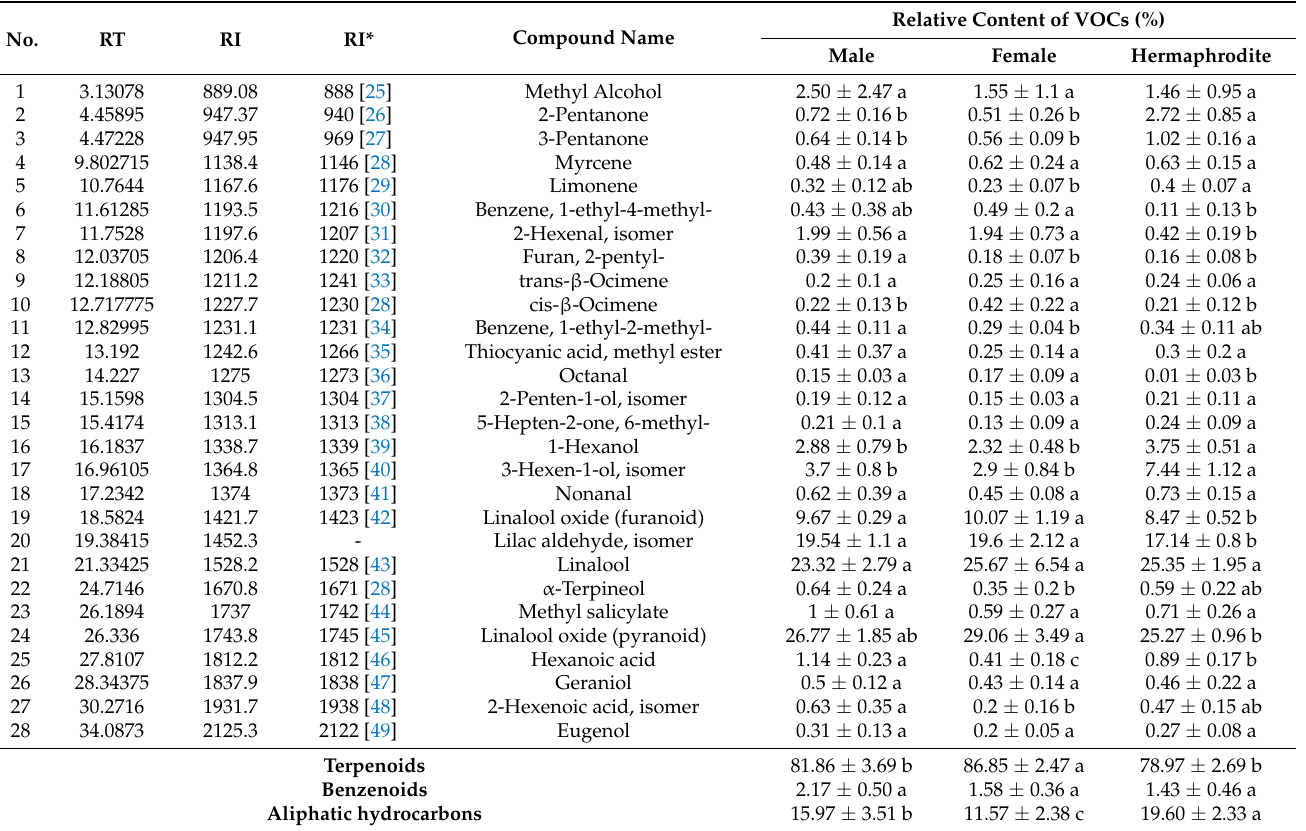
Table 2. Volatile compounds extracted from male, female, and hermaphrodite flowers of Eurya loquaiana